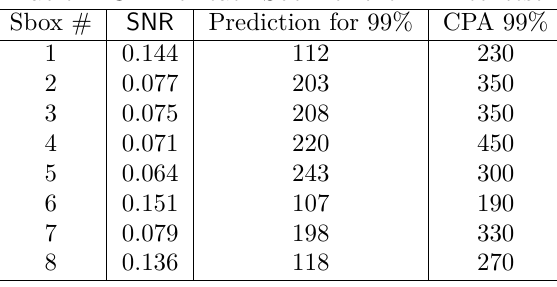
Table 2: SNR for each Sbox for the DPA